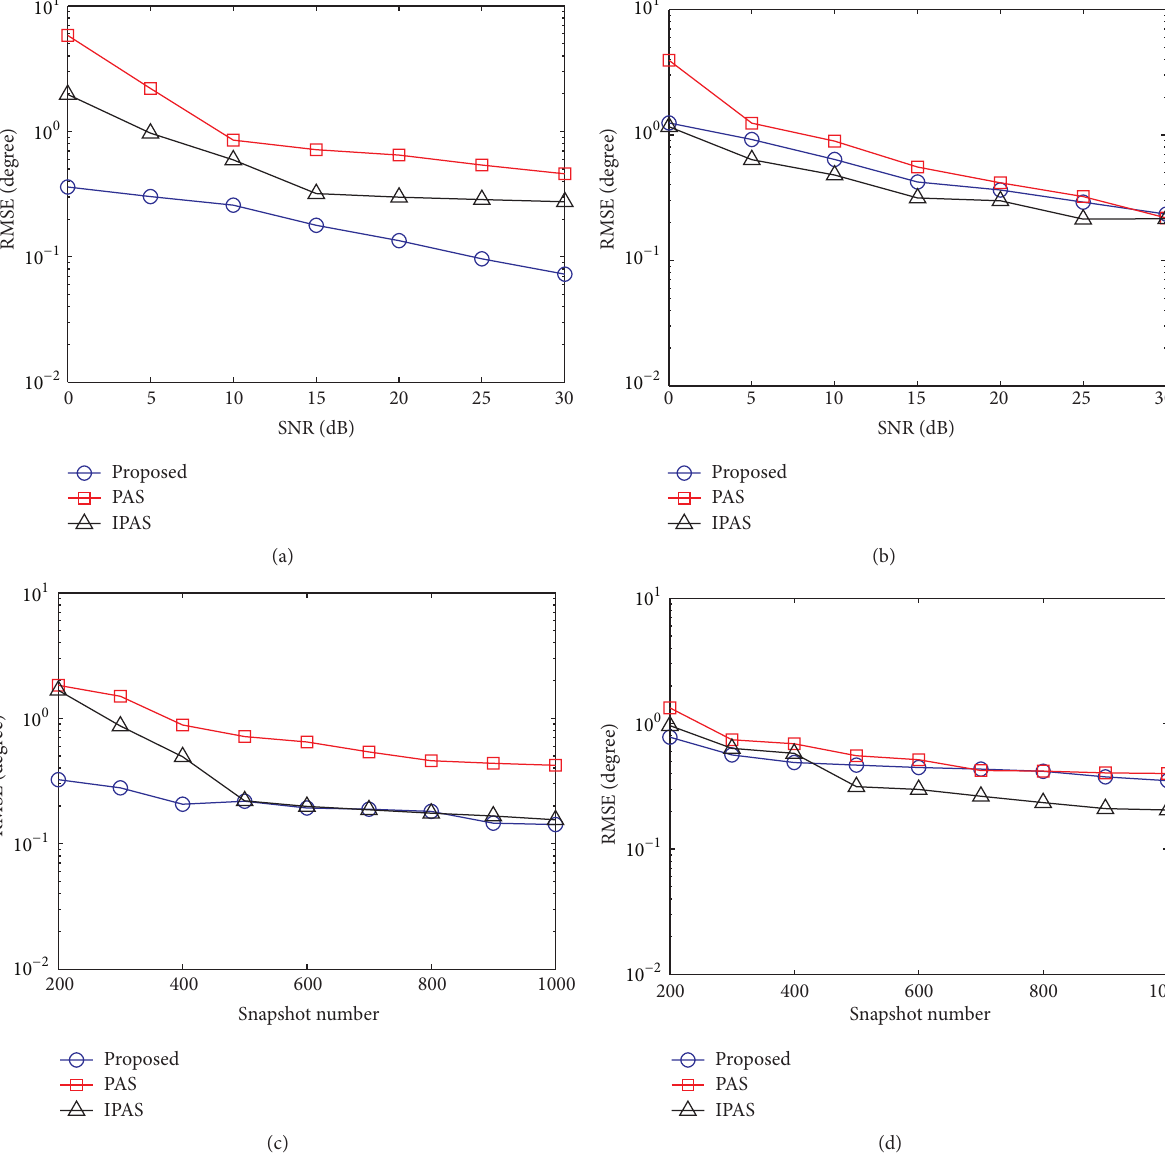
Figure 6: Comparison of RMSE of angle estimation of the proposed method, PAS method, and IPAS method versus SNR and snapshot number: (a) RMSE of uncorrelated angle estimation versus SNR with the fixed snapshot number 500; (b) RMSE of coherent angle estimation versus SNR with the fixed snapshot number 500; (c) RMSE of uncorrelated angle estimation versus snapshot number with the fixed SNR 20 dB; (d) RMSE of coherent angle estimation versus snapshot number with the fixed SNR 20